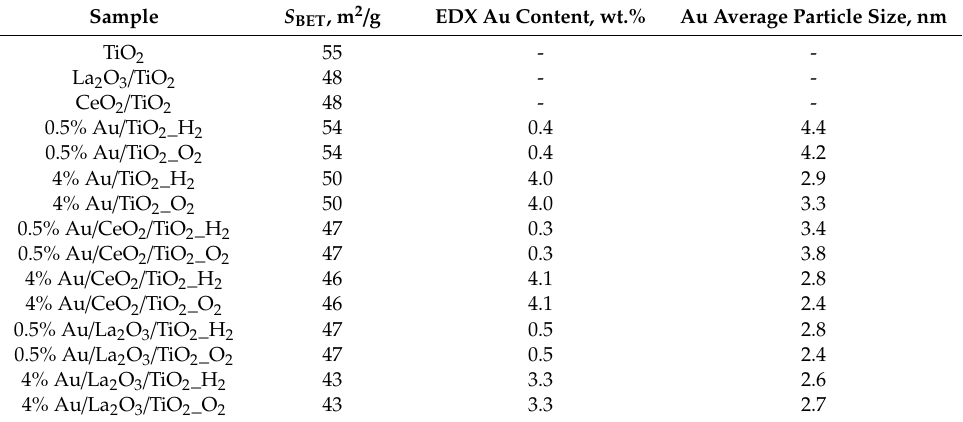
Table 6. Textural properties of supports and catalysts, analytical content and particle size of Au. Adapted from